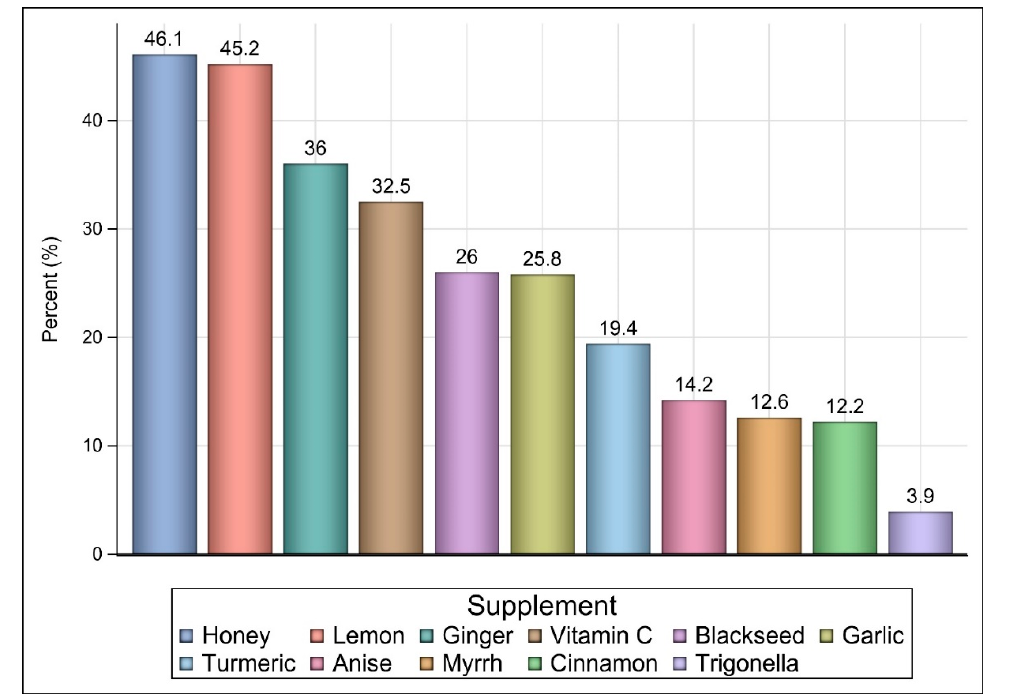
Figure 1. The most commonly utilized supplements among NP users (n = 955).